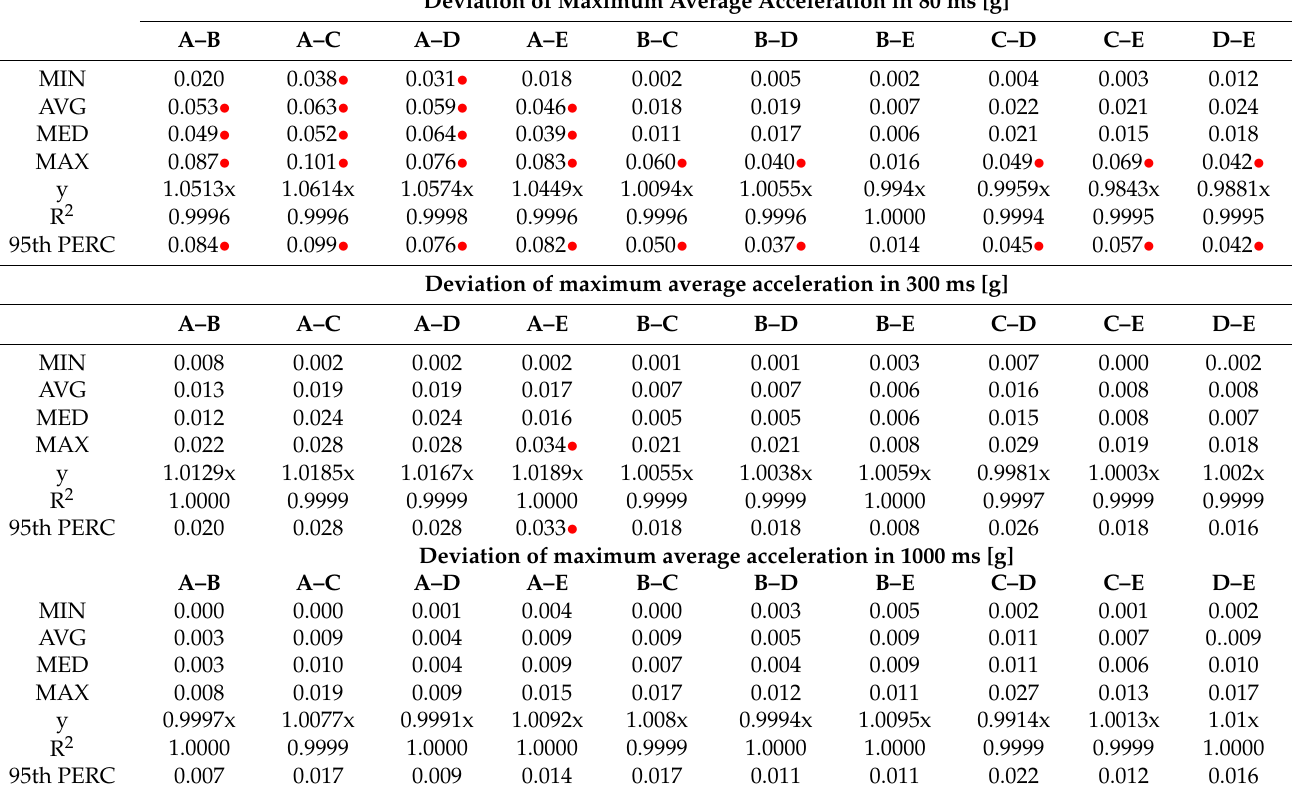
Table 3. Comparison of differences between sensors during passenger car braking. Deviation of Maximum Average Acceleration in 80 ms